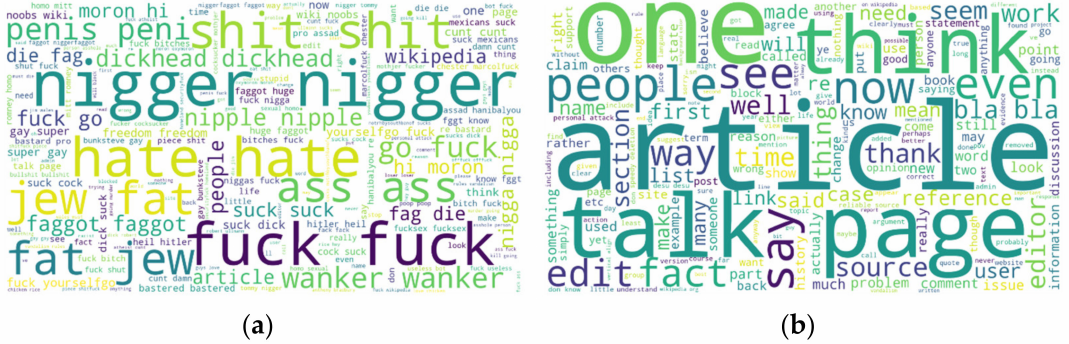
Figure 6. Word clouds of Wikipedia Attack dataset: ( a ) Attack and ( b )